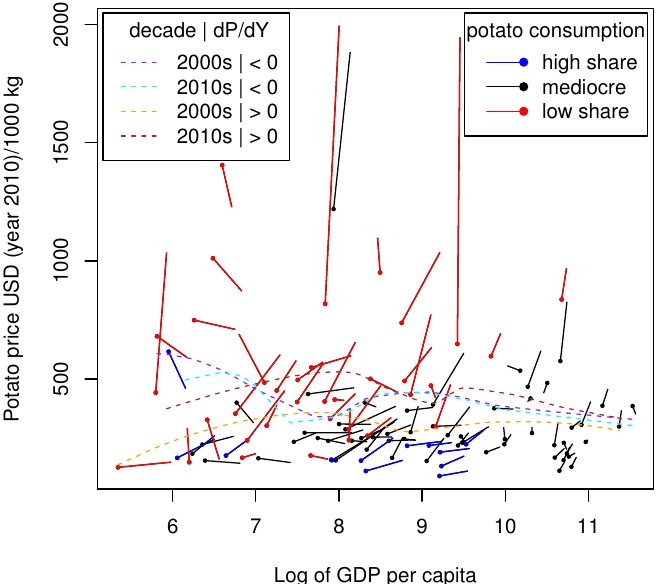
Figure 2. Logarithm of GDP per capita against potato producer price. Richer countries have less separable potato price behavior with respect to income, and weaker predictability as cross-sectional positions followed by local regression curves weakly if at all agree with potato statuses in individual country moves. For the poorest countries, the slopes ( dP/dY ) of the latest decade-mean moves are a better match to the signs of the slopes of cross-country local regression curves of the 2000s and 2010s. The slopes optimally rise for a normal good and descend for an inferior good status of the potato, aiding cross-sectional